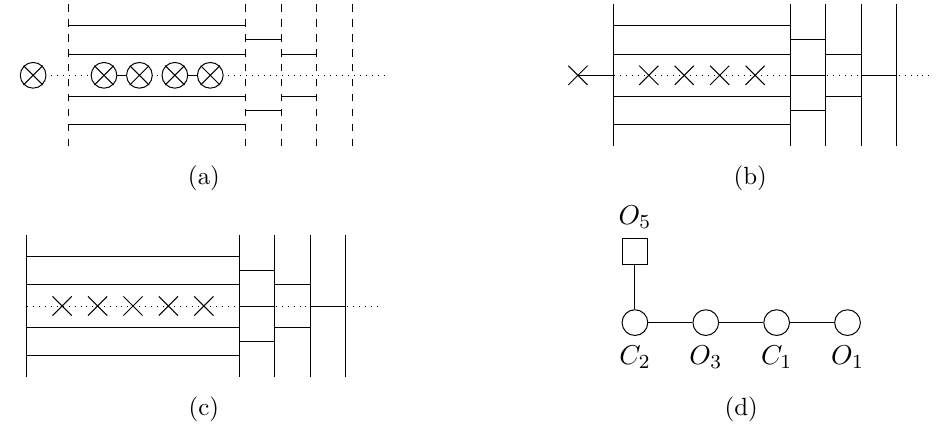
Figure 32. S-duality transformation of the maximal model of sp (2). The parameters of the initial model are n s = n d = 5, ~l d = (5 ; 3 ; 5 ; 3 ; 5), ~l d = (1 ; 1 ; 1 ; 1 ; 1) and rightmost O3-plane g O 3 + . (a) Higgs branch of the initial model. (b) Resulting model after performing S-duality on (a). (c) Resulting model after performing the collapse transition on (b). (d) Quiver obtained from (c). The Coulomb branch of the resulting model (d) is predicted to be the closure of the maximal nilpotent orbit of sp (2), corresponding to partition (cid:21) =